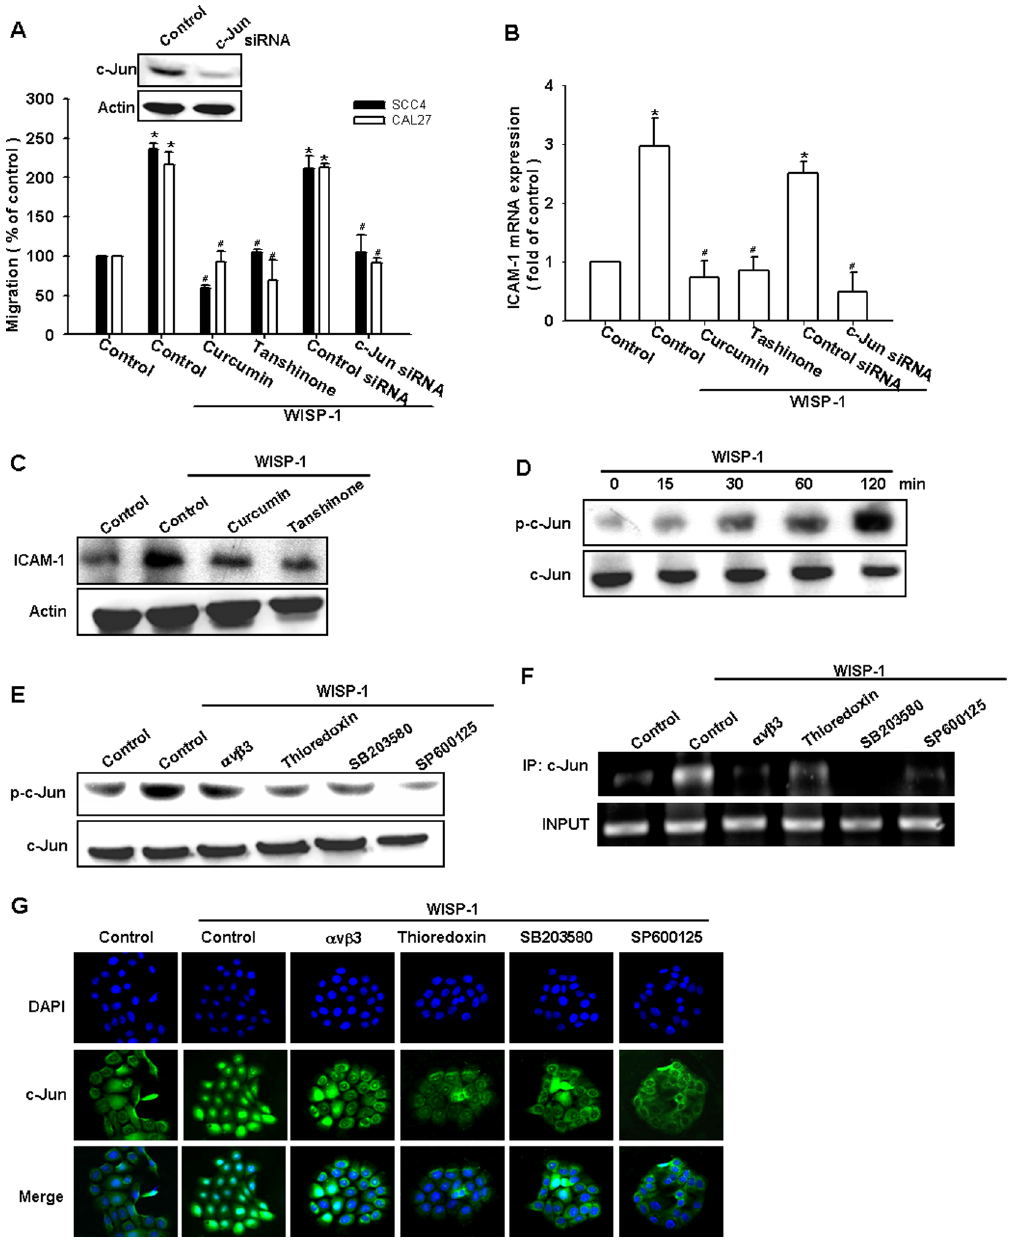
Figure 5. Activator protein 1 (AP-1) is involved in WISP-1–mediated migration in human OSCC cells. (A–C) Cells were pretreated for 30 min with curcumin (10 m M) and tanshinone (10 m M) or transfected for 24 h with c-Jun siRNA followed by stimulation with WISP-1 for 24 h. The in vitro migration and ICAM-1 expression were measured by the Transwell assay, qPCR, and western blotting (n=5). (D) SCC4 cells were incubated with WISP- 1 for the indicated time intervals, and c-Jun phosphorylation was examined by western blotting (n=4). (E–G) SCC4 cells were pretreated for 30 min with a v b 3 mAb, thioredoxin, SB203580, or SP600125 for 30 min followed by stimulation with WISP-1 for 120 min. The c-Jun phosphorylation, c-Jun binding to the AP-1 element, and c-Jun translocation into the nucleus was determined by western blotting, chromatin immunoprecipitation, and immunofluorocytochemistry (n=5). Results are expressed as the mean 6 SEM; *, p , 0.05 compared with the control; # , p , 0.05 compared with the WISP-1–treated